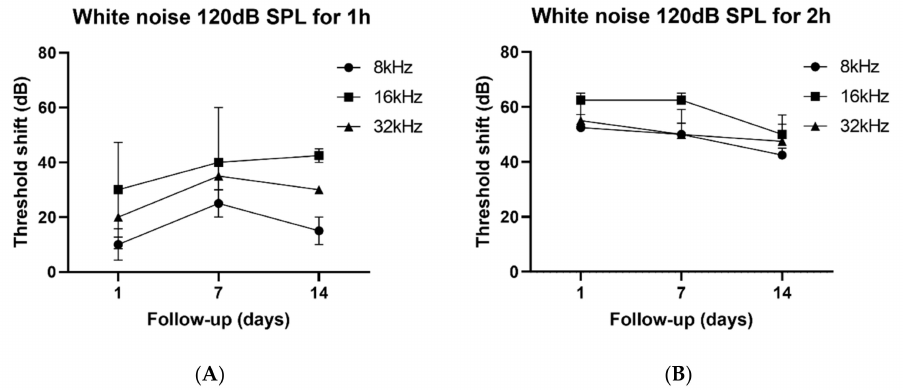
Figure 1. Noise exposure strategies: white noise 120 dB SPL for 1 h (( A ) moderate permanent threshold shift (PTS), n = 4) and 2 h (( B ) severe PTS, n = 4). The baseline auditory brainstem response (ABR) thresholds for moderate PTS (dB SPL) were 30 ± 4.08 at 8 kHz), 30 ± 5.77 at 16 kHz, and 35 ± 2.89 dB at 32 kHz, respectively. The baseline ABR thresholds for severe PTS (dB SPL) were 35 ± 2.89 at 8 kHz, 32.5 ± ‘2.50 at 16 kHz, and 40 ± 4.08 at 32 kHz, respectively. The Error bar indicates